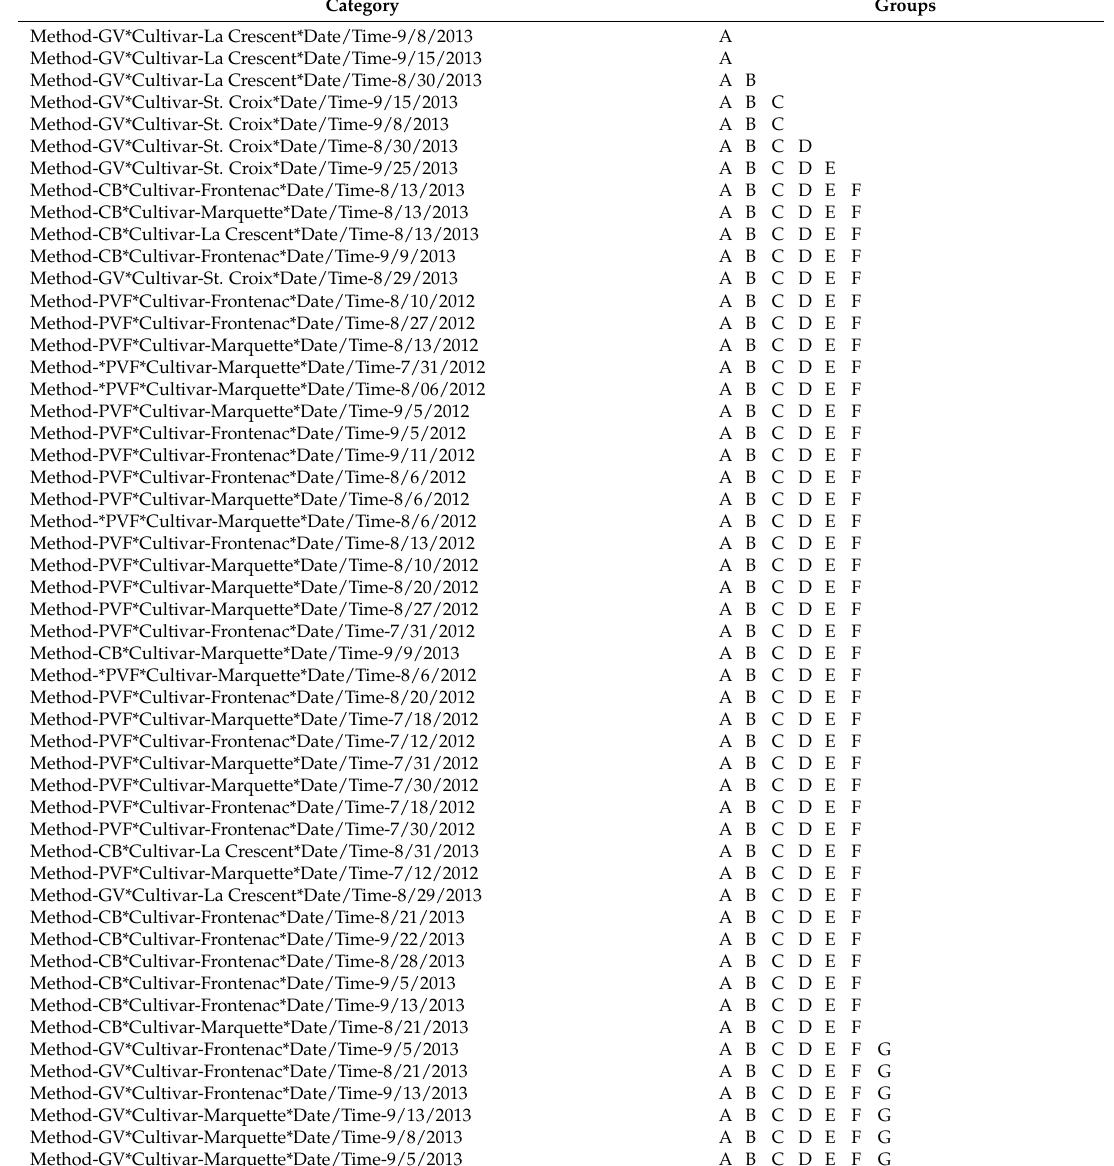
Table A2. Results of Tukey HSD